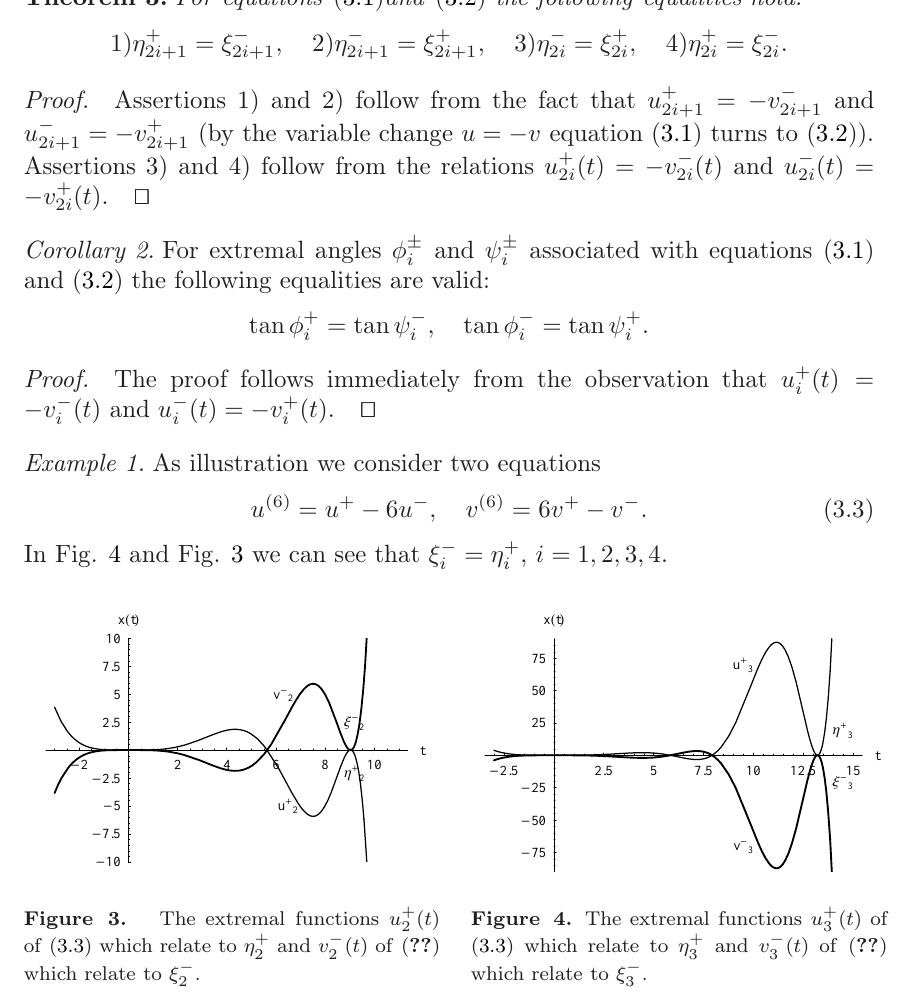
( t ) of 3 and v − ( t ) of ( ?? ) 3 3 3